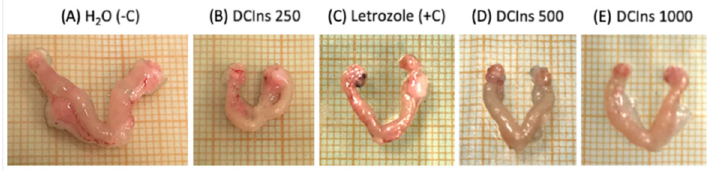
Figure 2. Macroscopic view of mouse uterus-ovary complexes at the end of the 21 day-treatment. Gross morphology of typical uteri and ovaries from mice that received, from left to right: ( A ) plain water (negative control), ( B ) DCIns 250, ( C ) letrozole (positive control), ( D ) DCIns 500 and ( E ) DCIns 1000. Note the longer extension and thicker appearance of a typical uterus from control mice ( A ) compared with the shorter and thinner appearance of the uteri from DCIns- and letrozole-administered mice ( B – E ). All uteri are shown at the same scale (mm).